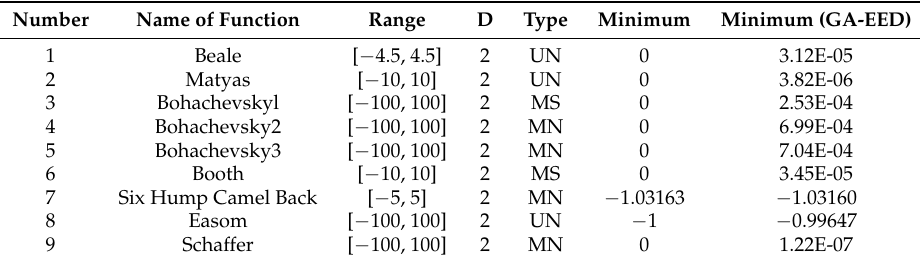
Table 10. Further benchmarking of GA-EED from